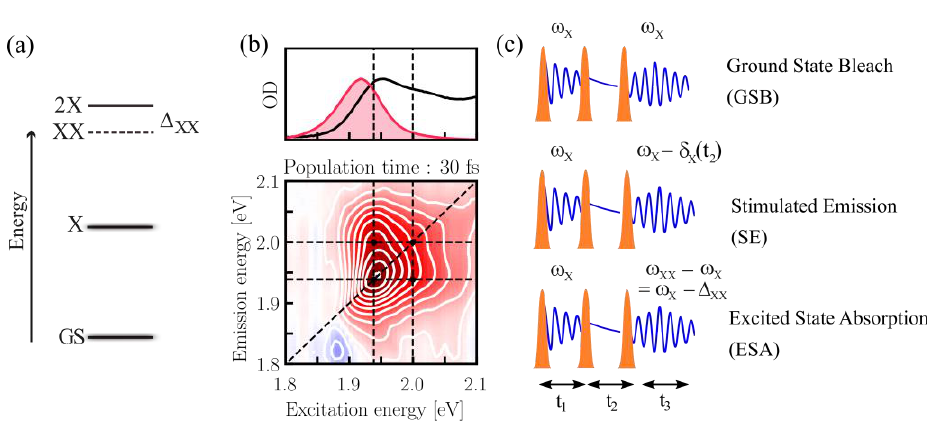
Fig. 1. (a) Coarse structure of the single-exciton (X) and the biexciton (XX), with a frequency detuned from 2X due to the binding energy  XX .(b) Example 2D correlation spectrum of colloidal CdSe nanocrystals at a population time of 30 fs. ESA shown in blue, GSB and SE in red.(c) The three signals contributing to the 2D spectrum. The GSB pathways oscillate at  x during t 1 and t 3 . The SE pathways oscillate at  x during t 1 but at  x –  x (t 2 ) during t 3 , where  x is the Stokes shift. The ESA pathways oscillate at  x during t 1 but the frequency is detuned by the binding energy  xx during t 3 .